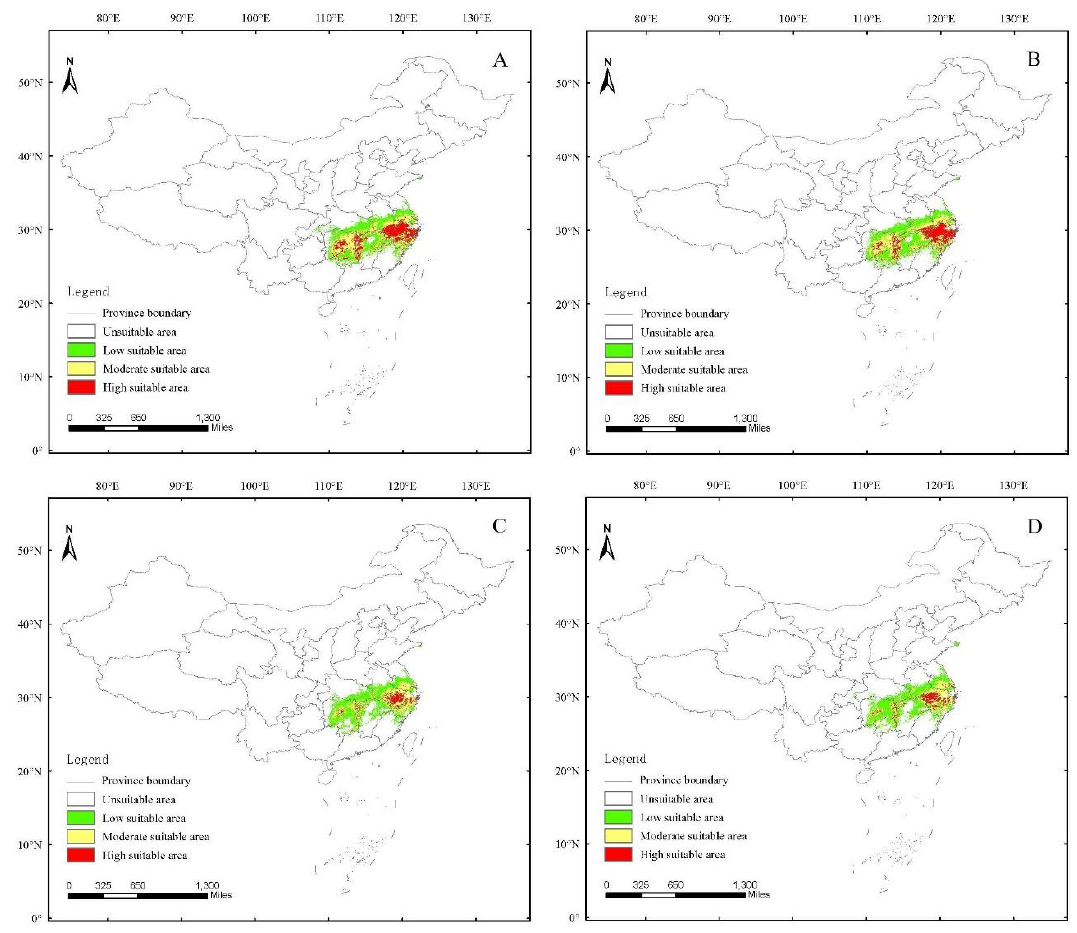
Figure 7. Future potential distribution of Hippotiscus dorsalis in China. ( A ) is future potential distribution of Hippotiscus dorsalis under RCP2.6 in 2050s; ( B ) is future potential distribution of Hippotiscus dorsalis under RCP2.6 in 2070s; ( C ) is future potential distribution of Hippotiscus dorsalis under RCP4.5 in 2050s; ( D ) is future potential distribution of Hippotiscus dorsalis under RCP4.5 in 2070s.